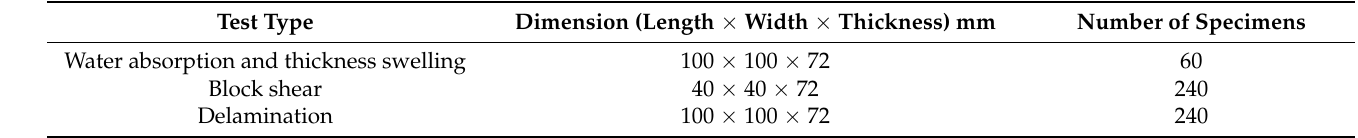
Table 2. Dimension and number of specimens.